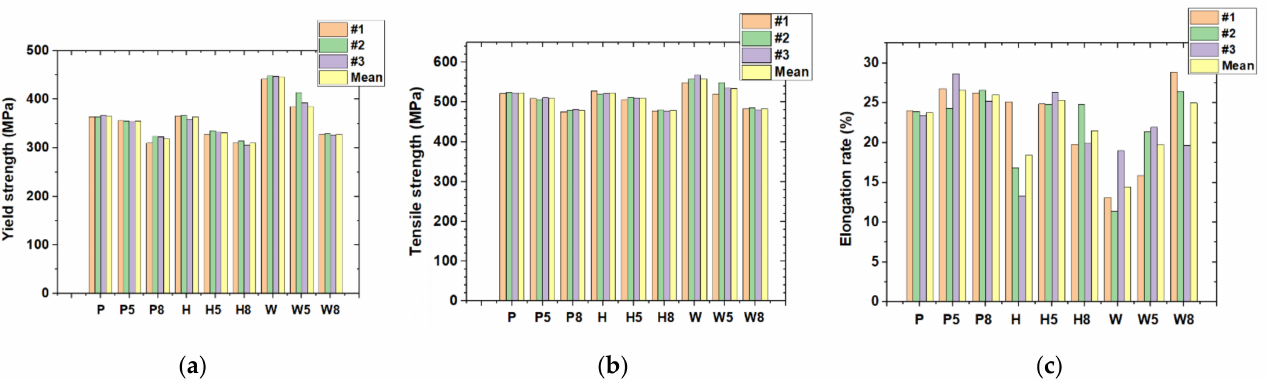
Figure 10. Comparison of yield stresses. P, parent material non heat treated; P5, parent heat treated at 590 ◦ C; P8, parent heat treated at 800 ◦ C; H, HAZ non heat treated; H5, HAZ heat treated at 590 ◦ C; H8, HAZ heat treated at 800 ◦ C; W, weld metal non heat treated; W5, weld metal heat treated at 590 ◦ C; W8, weld metal heat treated at 800 ◦ C. ( a ) Yield stress; ( b ) tensile stress; and ( c ) elongation rates.